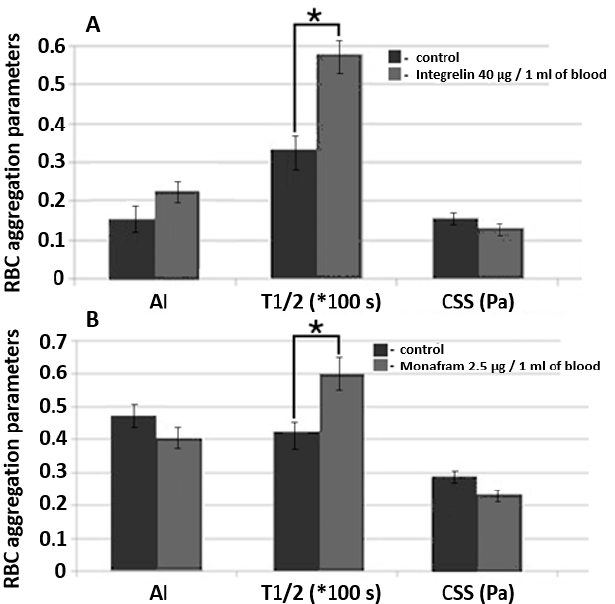
Figure 7. A comparative diagram of RBC aggregation parameters measured using diffuse light scattering implemented by RheoScan And-300 aggregometer in samples of whole blood supplemented with glycoprotein IIb/IIIa agonist commercial pharmaceuticals Integrelin ( A ) and Monafram ( B ). Blood incubation time was 30 min at 37 °C. Control and experimental groups included 3 different donors in each group. Data averaging was performed within each group. The mean values and error bars designate standard deviations; * p < 0.05 ( t -test); AI, RBC aggregation index; T 1/2 , characteristic time of aggregate formation; CSS, critical shear stress, sufficient to prevent spontaneous aggregation (hydrodynamic strength of the aggregate). The parameters are presented under one scale, measurement units for each parameter are indicated in brackets.